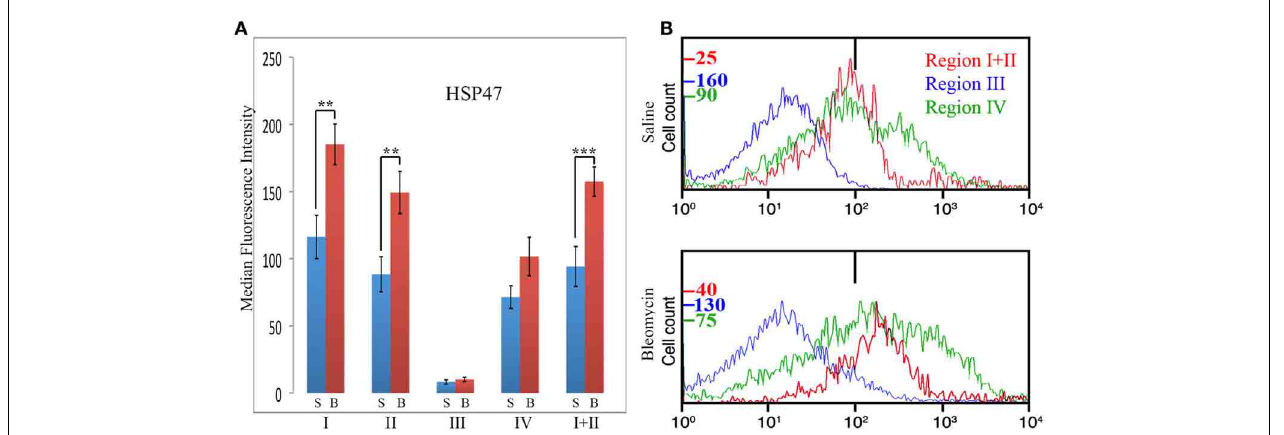
FIGURE 7 | Collagen Chaperone HSP47 in Regions I–IV. (A) Total lung cells from saline- and bleomycin-treated mice sacrificed 28 days after initiation of treatment were immunolabeled for CD45, Pro, and HSP47. HSP47 levels in Regions I–IV, and I + II are shown in terms of the average ± s.e.m. of the median fluorescence intensity of each of 11 saline and 17 bleomycin mice. S, saline; B, bleomycin. (B) In some of the experiments that make up (A) , cells from the indicated Regions from CD45-Pro scatter plots were selected and